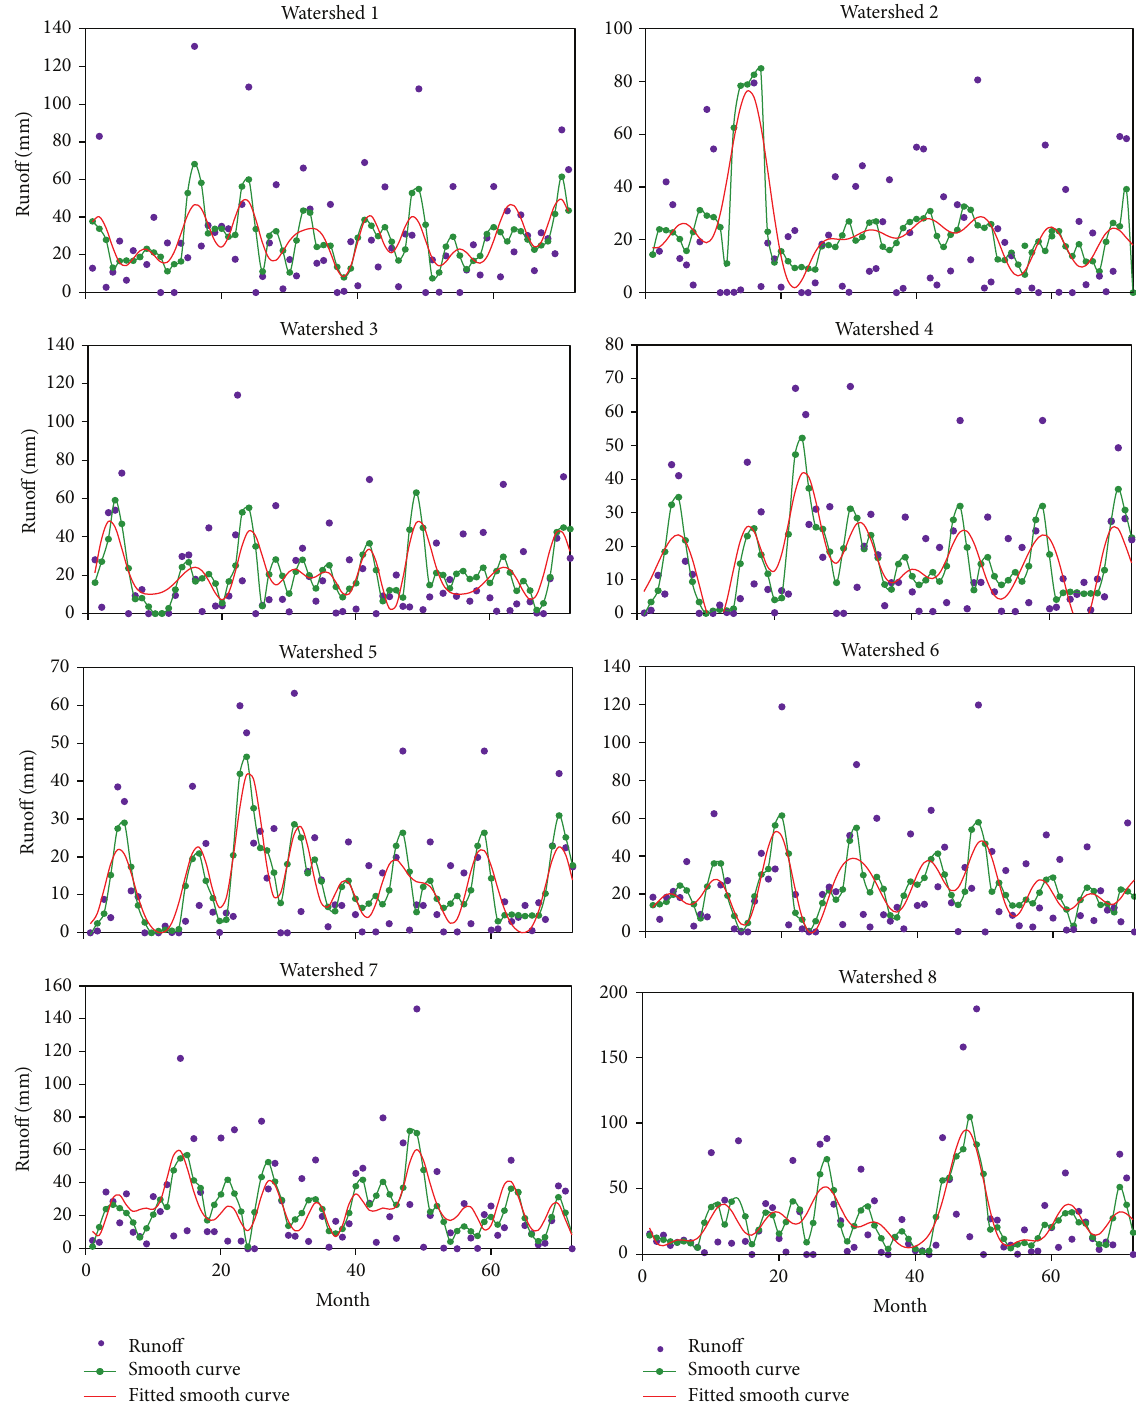
Figure 7: Monthly runoff data with fitted smooth curve of eight